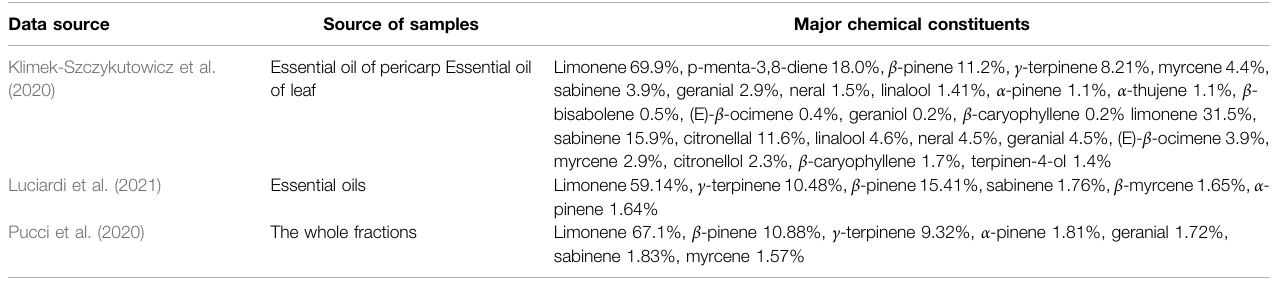
TABLE 3 | Major chemical constituents of lemon plants and essential oils.